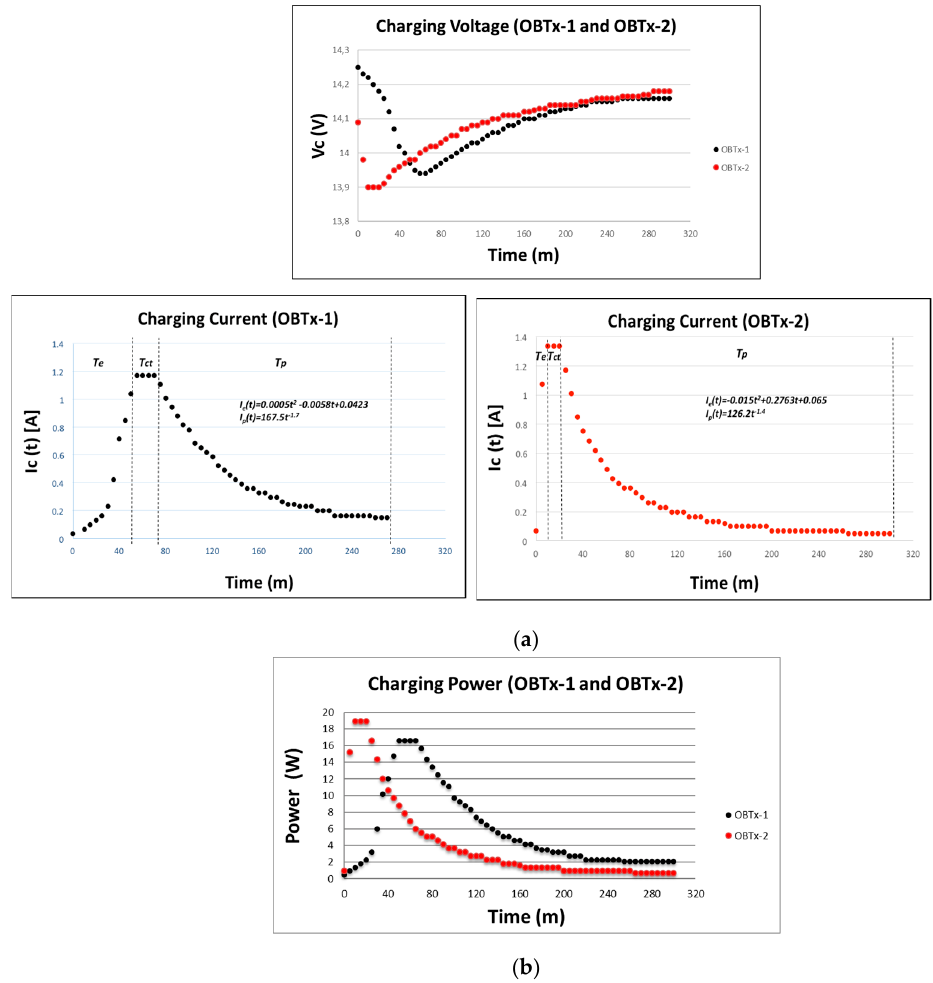
Figure 9. ( a ) Evolution of V c and I c in time. ( b ) Evolution of power consumption in time ( T c ).